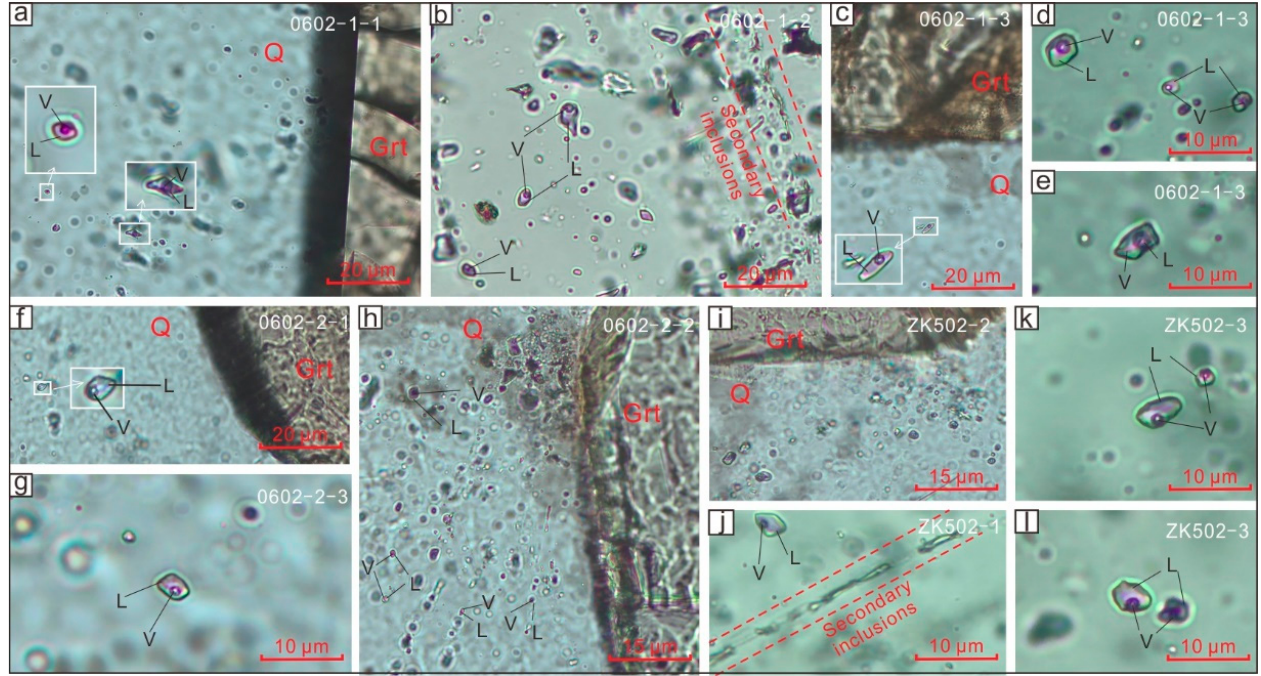
Figure 11. Microphotographs demonstrating the combination characteristics of fluid inclusions in quartz symbiotic with garnet at various depths ( a ‒ c, f ‒ i, k) and characteristics of isolated fluid inclusions ( d , e , j ‒ l ); a ‒ b (+5 m); c ‒ g ( − 200 m); h ‒ l ( − 400 m). Abbreviations: L = liquid, V = vapor.